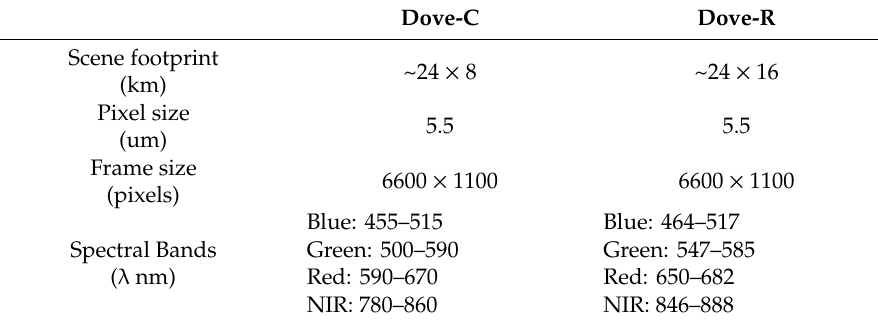
Table A1. PlanetScope constellation